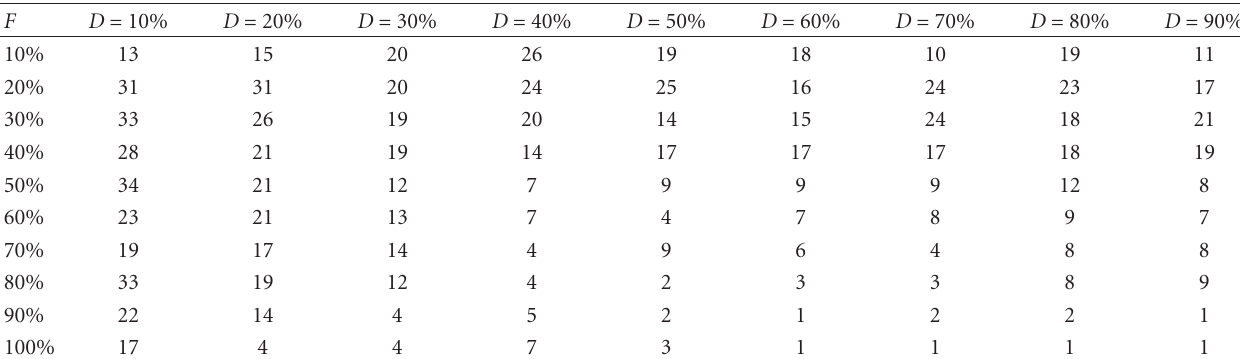
Table 13: The comparison of RMSE obtained when using standard PSO, CPSO, and standard fuzzy model with holdout method for housing data with C = 3. Standard PSO % of data